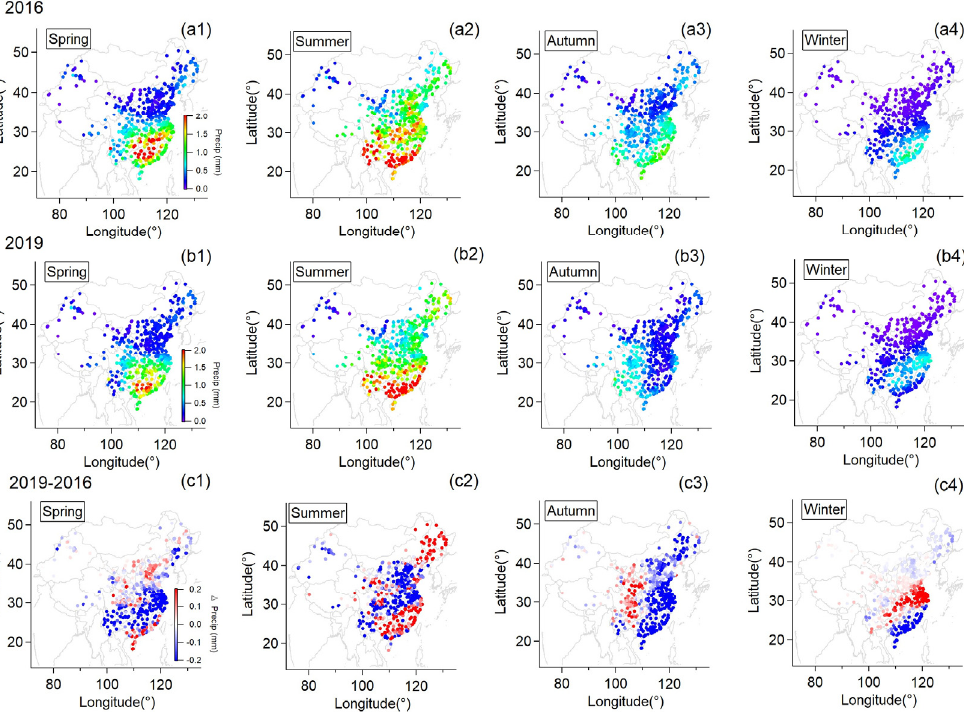
Figure 1. Seasonal mean of daily maximum precipitation for individual monitoring stations for 2016 ( a1 – a4 ) and 2019 ( b1 – b4 ). The difference of this parameter between the two years ( c1 – c4 ).